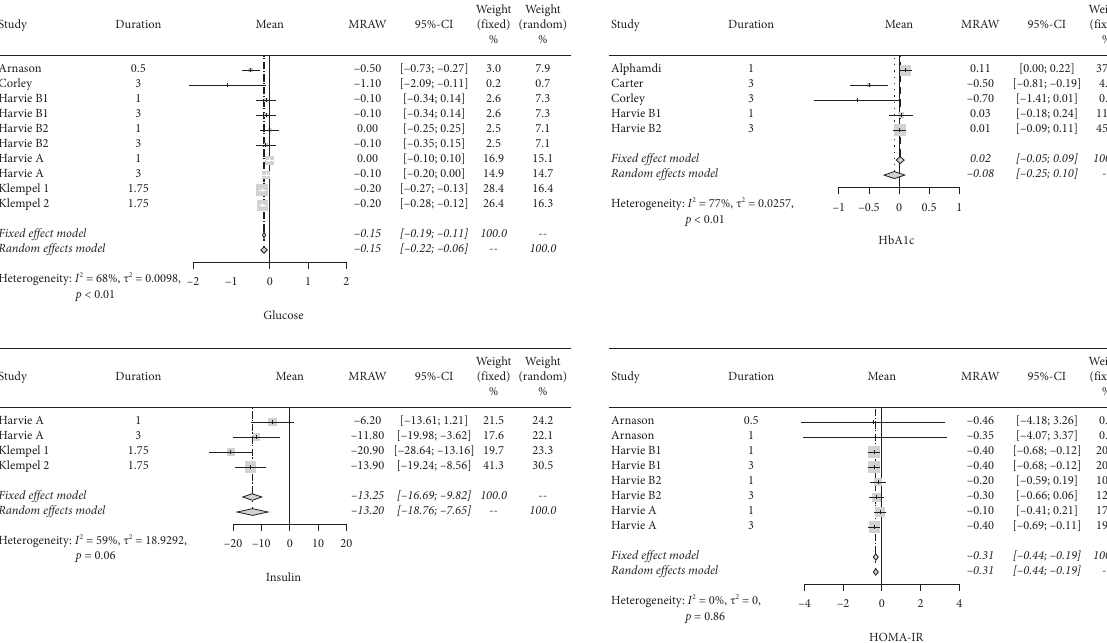
Figure 2: Forest plots for blood glucose, insulin, HbA1c, and